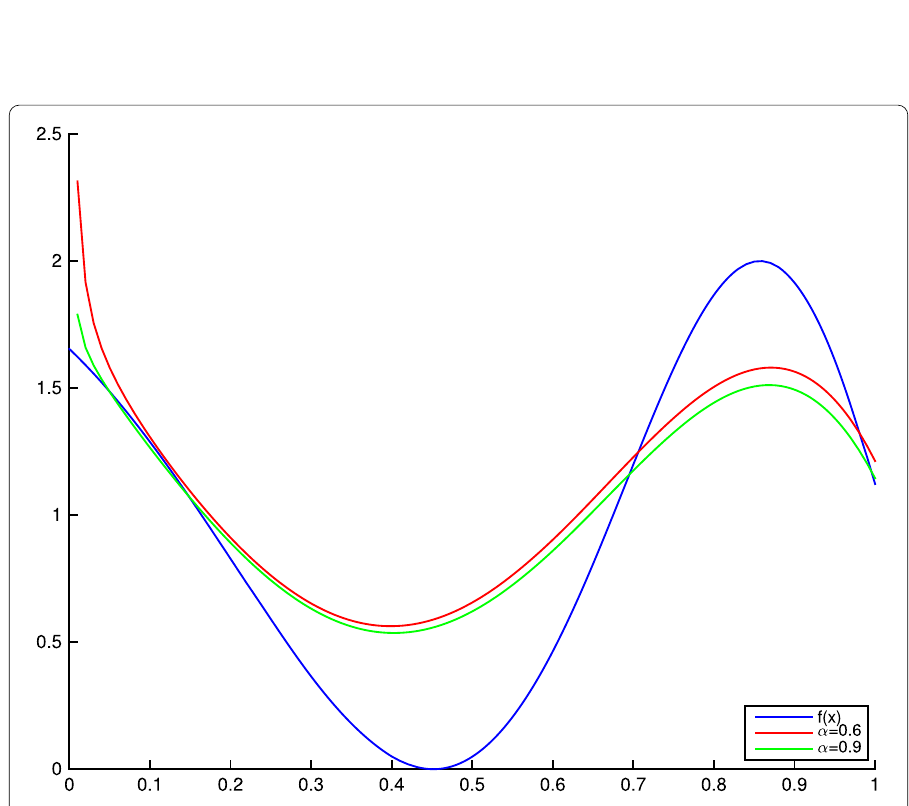
Figure 2 Convergence of T n , q , α ( f ; x ) to f ( x ) for fixed q =